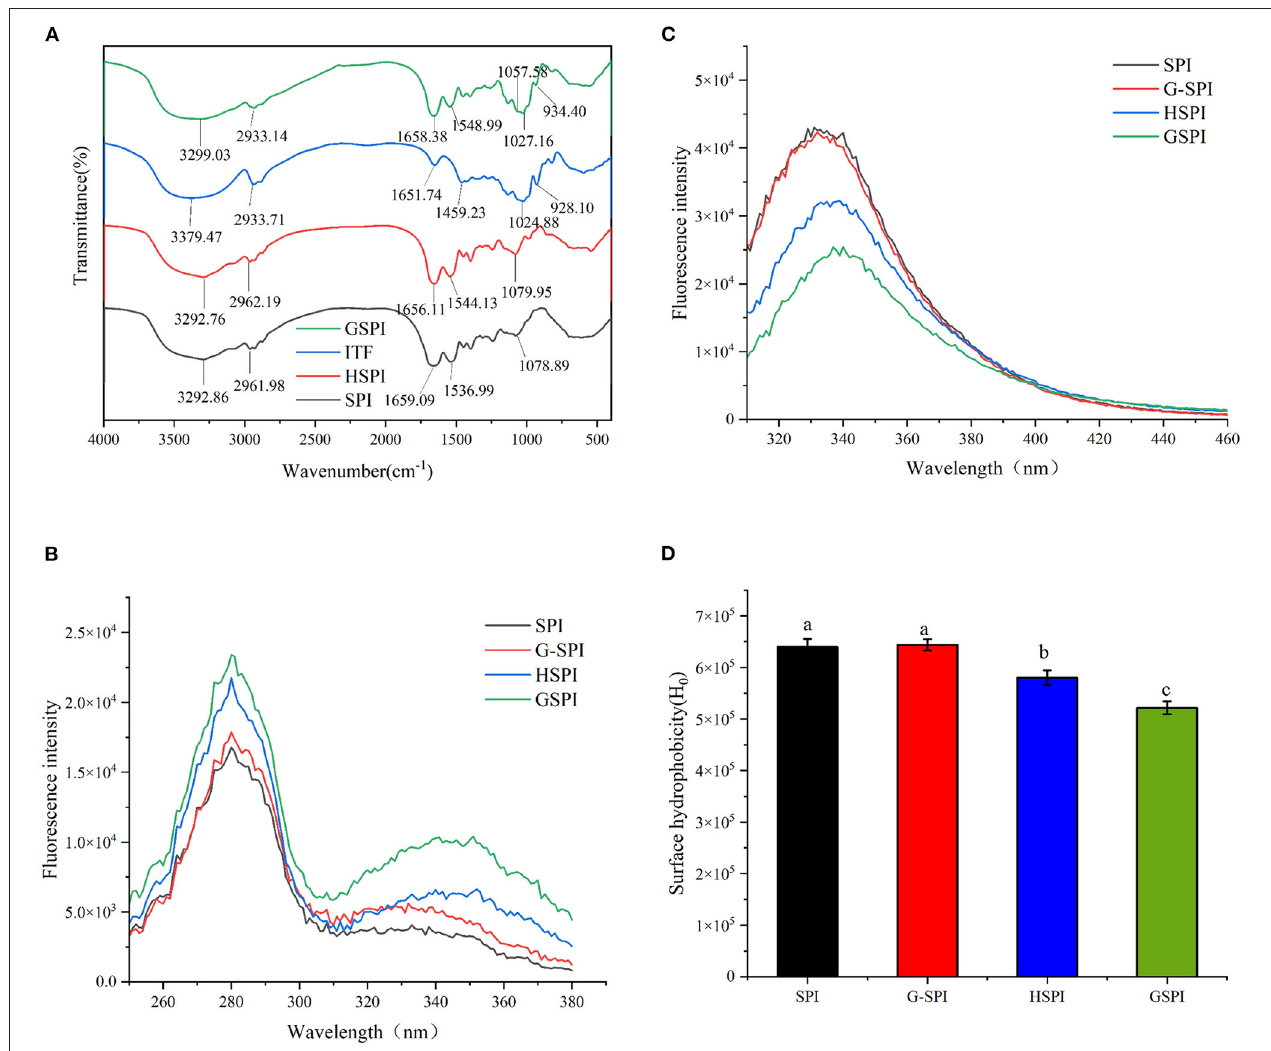
FIGURE 1 | (A) The Fourier transform infrared spectroscopy of SPI, HSPI, ITFs, and GSPI. (B) Fluorescence excitation spectroscopy of 0.1 mg/ml SPI, HSPI, G-SPI, GSPI, T = 293K, pH = 7.0, λ ex = 280nm, and λ em = 310–460nm. (C) Fluorescence emission spectroscopy of 0.1 mg/ml SPI, HSPI, G-SPI, GSPI, T = 293K, pH = 7.0, λ em = 420nm, and λ ex = 250–380nm. (D) Surface hydrophobicity of 0.01–0.09 mg/ml SPI, HSPI, G-SPI, GSPI, T = 293K, pH = 7.0, λ em = 470nm, and λ ex = 390 nm. Different letters indicate significant